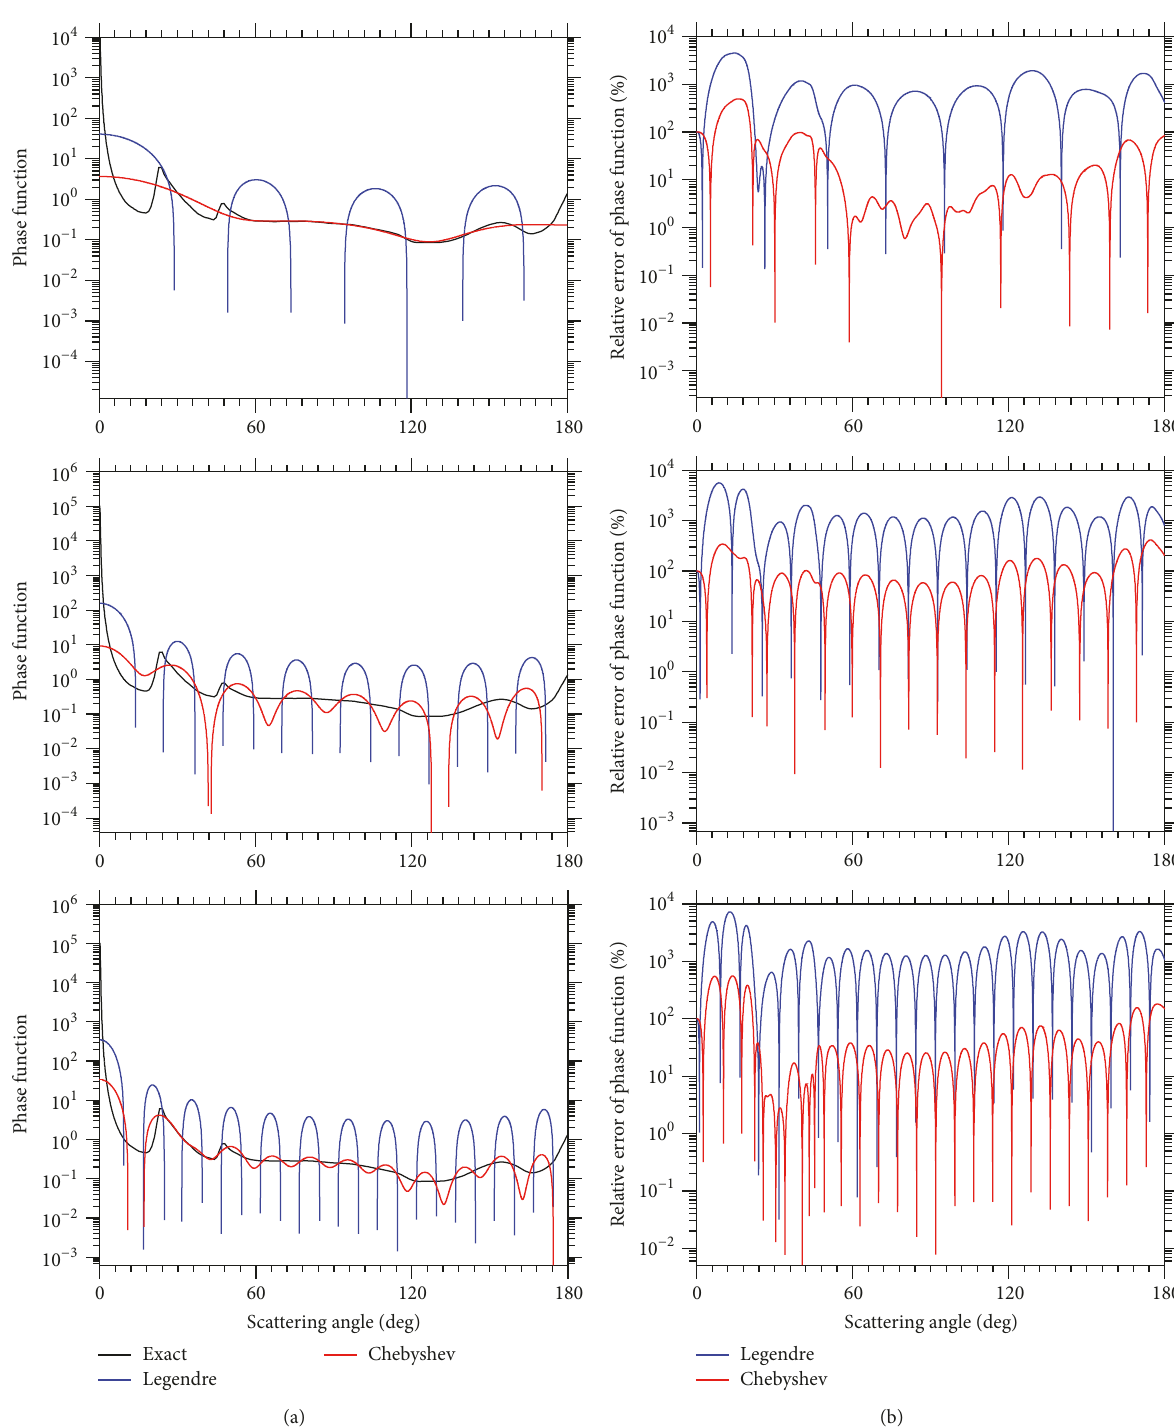
Figure 6: Phase function of ice cloud (a) and relative error of phase function (b) in 8, 16, and 24